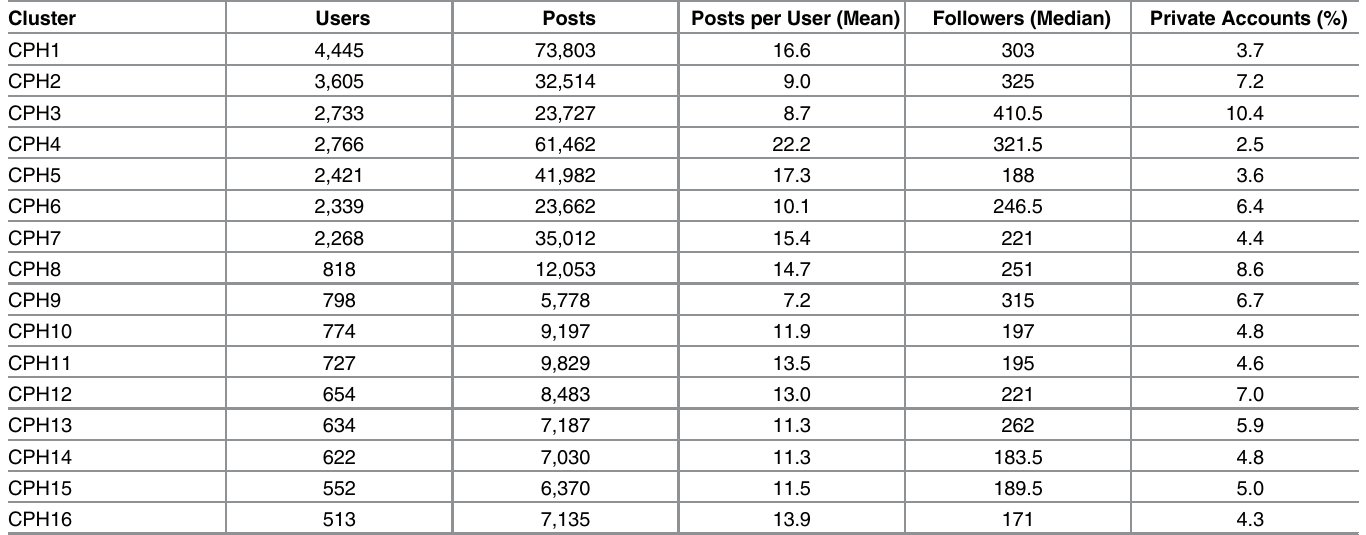
Table 4. Clusters detected in Copenhagen.